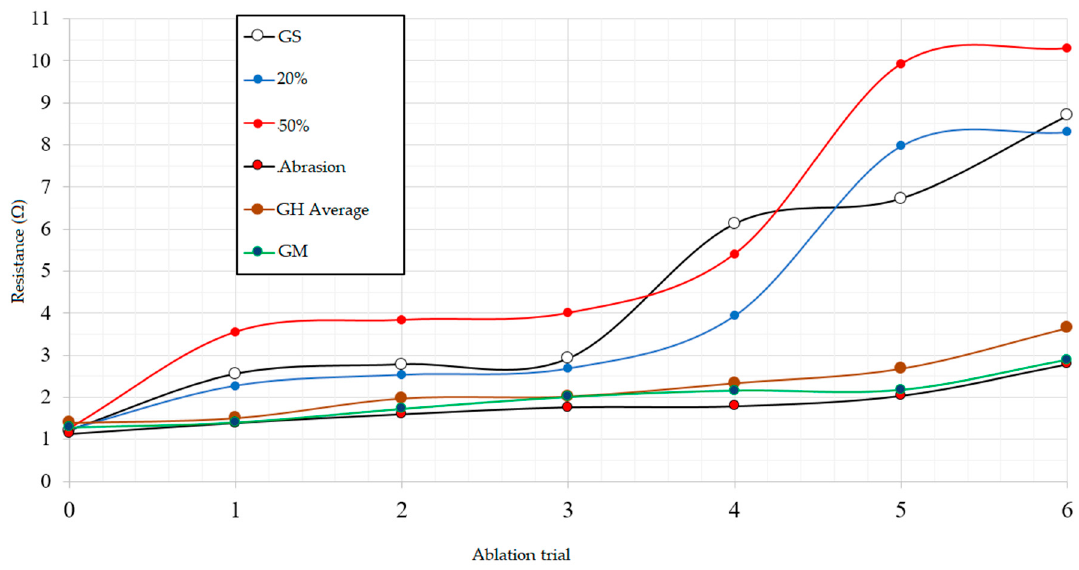
Figure 22. The resistance of each element after each ablation cycle with various processing strategies.